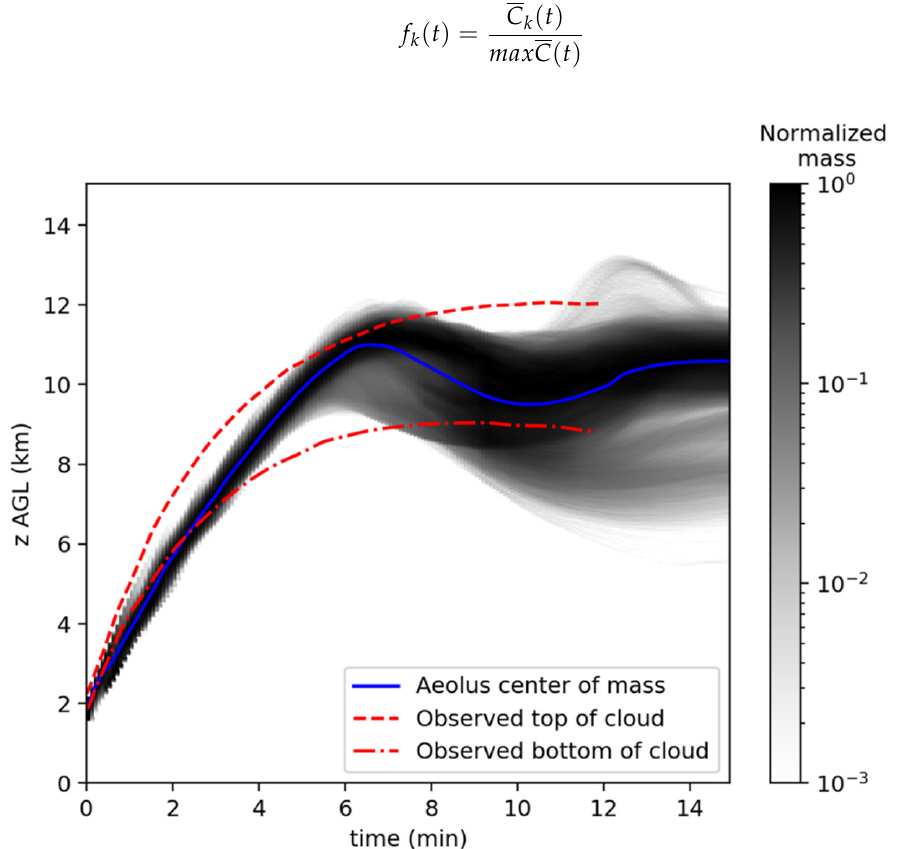
Figure 14. Simulated cloud rise with entrainment factor of 0.5. The average concentration of cloud gas normalized by the maximum value at each time is shown in the shaded grey, the center of mass of simulated cloud is shown in solid blue profile, and the red dashed and dash-dotted profiles show the observed cloud top and bottom. Similar to simulations by Arthur et al. (2021), the cloud height is underpredicted in the first 2 min post detonation [32]. At later times, the majority of the cloud mass is contained between the observed cloud top and bottom, as shown in Figure 14.